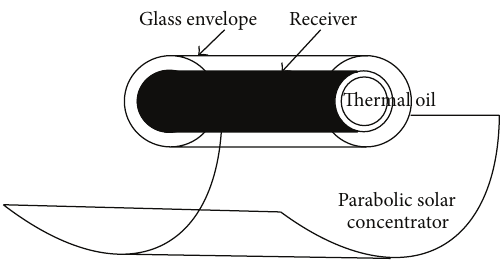
Figure 1: The schematic diagram of a parabolic trough solar col- lector system.